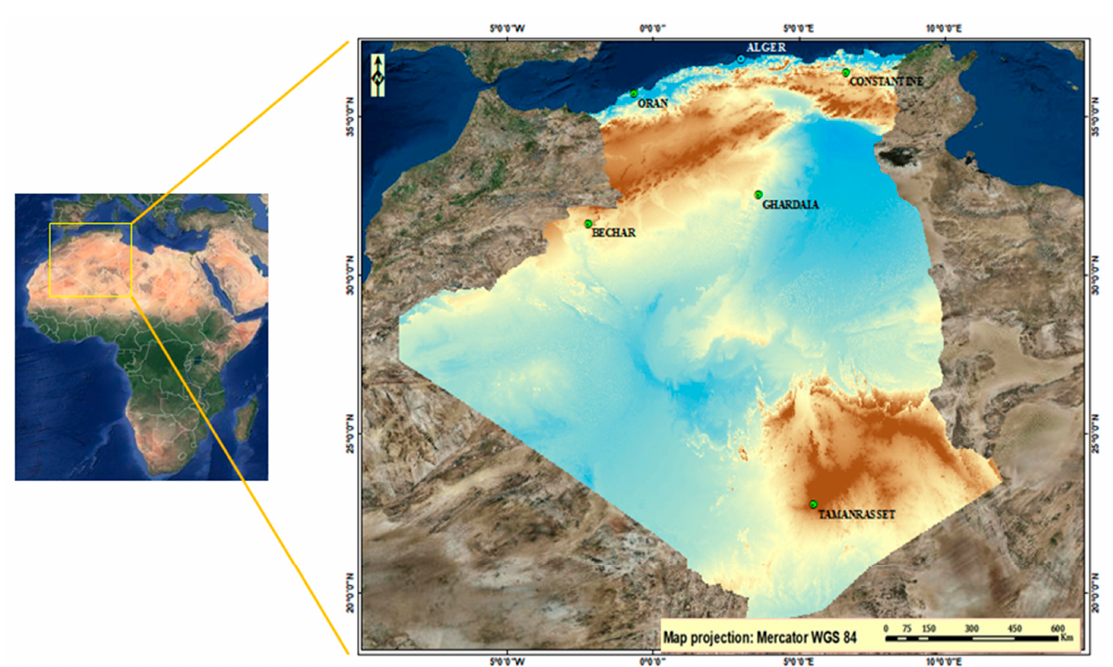
1 Figure 1. Position of the six selected Algerian cities for the study.